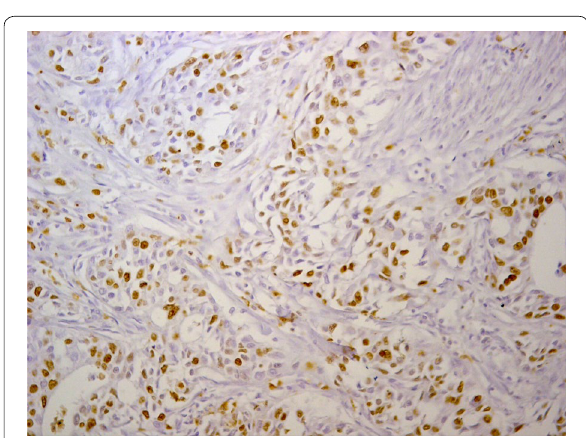
Table 2 Correlation between AR expression and tumor grade in the studied urothelial bladder carcinoma patients AR negative patients